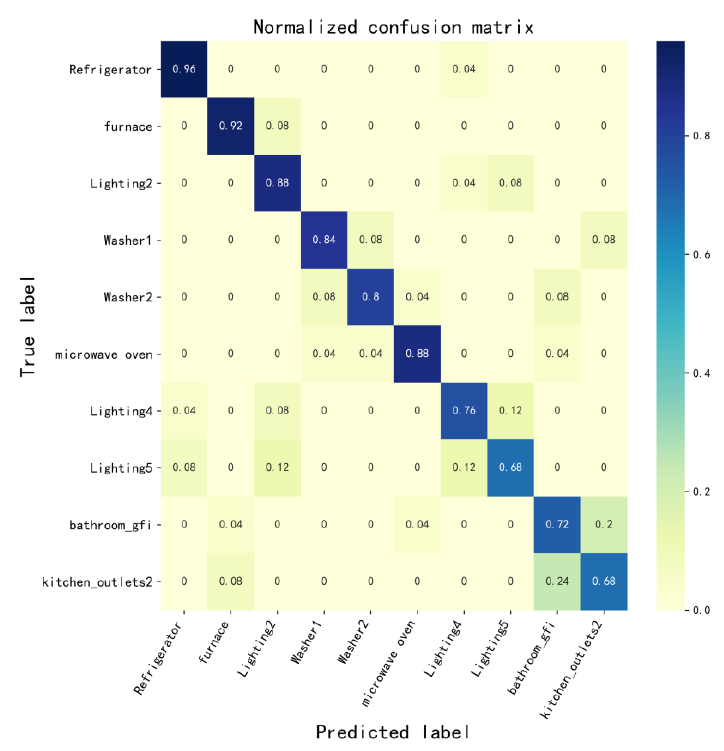
Figure 9. Features performance on REDD based on the resampling method.